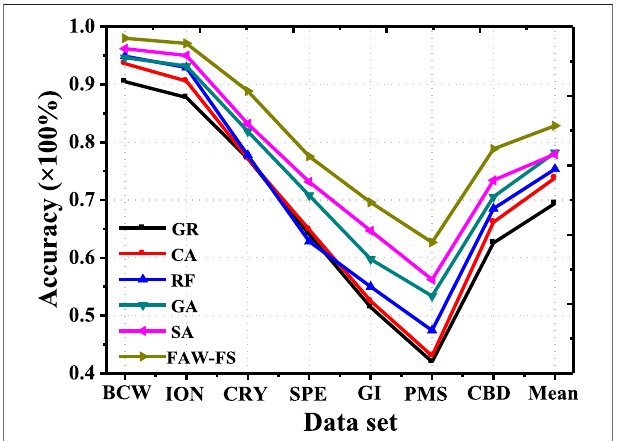
FIGURE 6 | Comparison on the classi fi cation accuracy of different algorithms under the feature of SVM.